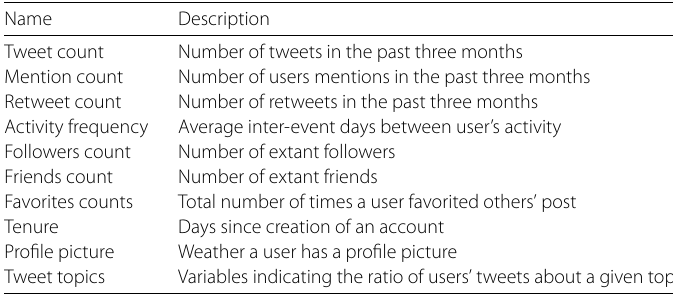
Table 5 List of